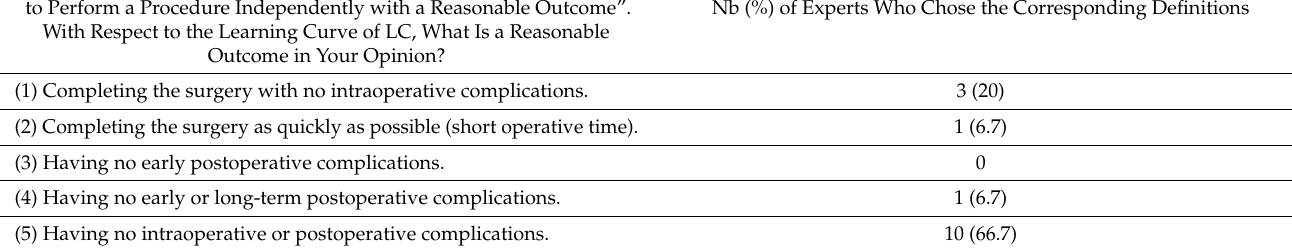
Table 1: LC: laparoscopic